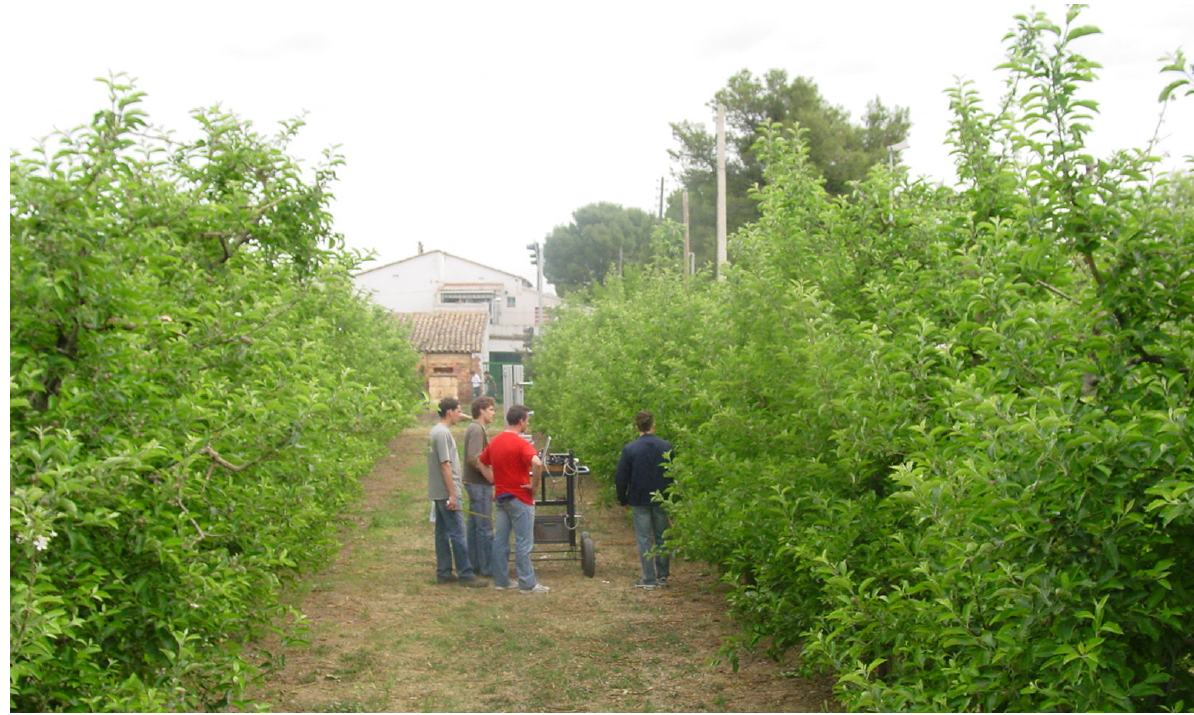
Figure 4. Malus domestica , Borkhausen cv. ‘Golden Delicious’ apple orchard where the field trials were carried out.